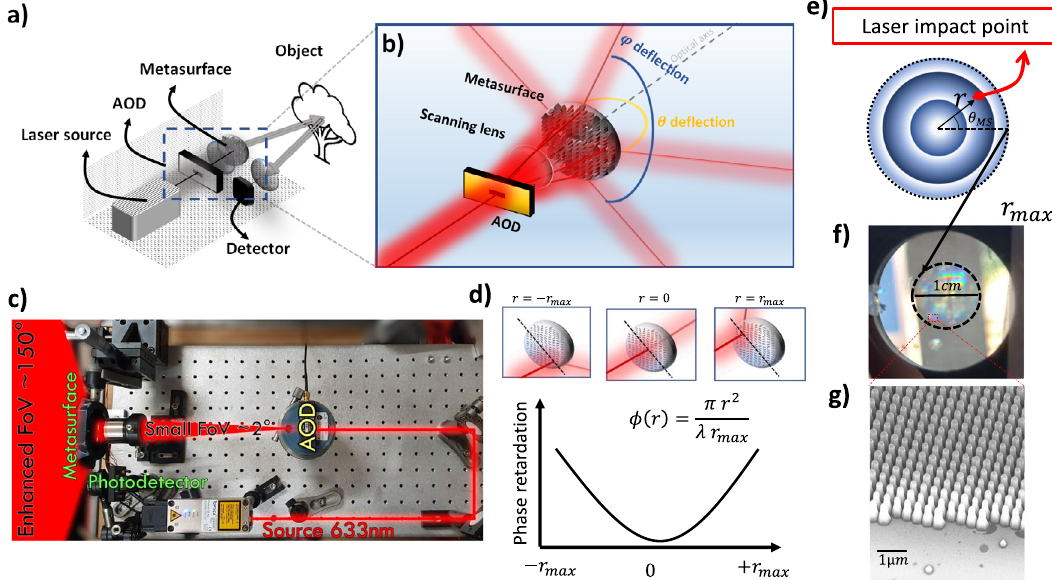
Fig. 1 | Concept of a metasurface-augmented FoV LidAR. a Schematic repre- sentation of the LIDAR system. A triggered laser source, emitting single pulses for ToFdetection,isdirectedtoasynchronizedacousto-opticde fl ector(AOD)offering ultrafast light scanning with low FoV (~2°). The de fl ected beam is directed to a scanning lens to scan the laser spot on the metasurface at different radial and azimuthal positions. The transmitted light across the metasurface is deviated according to the position of the impinging beam on the component to cover a scanning range between (cid:2) 75 (cid:4) and 75 (cid:4) . The scattered light from the scene is col- lected using a fast detector. Data are processed to extract the single echo ToF for